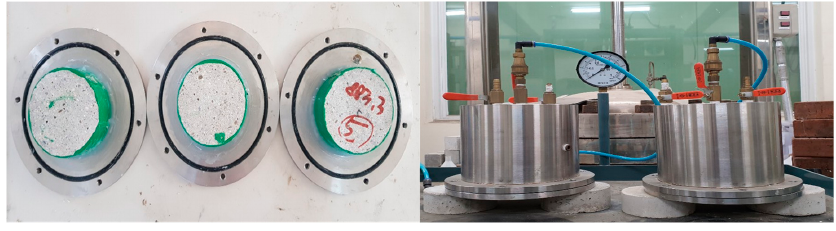
Figure 4. Water penetration test setup.